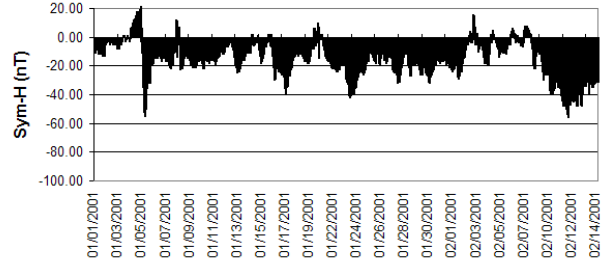
Fig. 1. SYM-H index for the period between 1 January and 15 February 2001 (collected at 1min intervals). Only negative values are